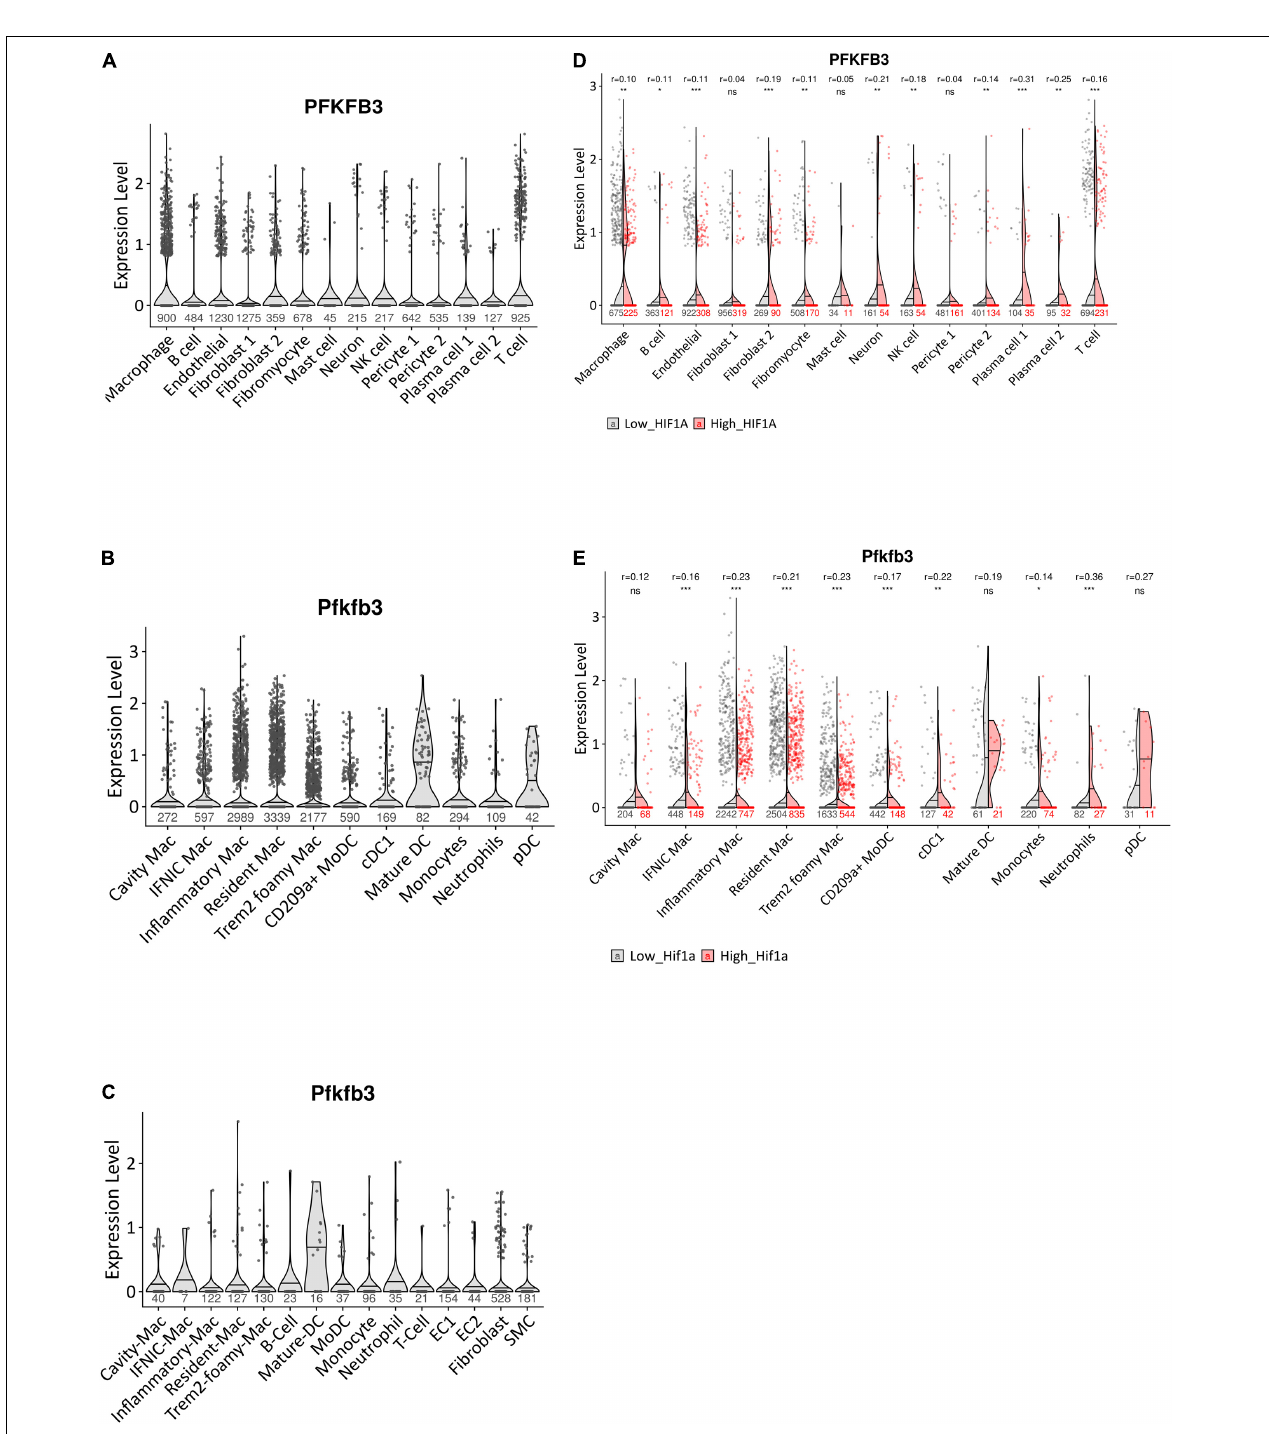
FIGURE 1 | Expression pattern of PFKFB3/Pfkfb3 in human and murine atherosclerosis. (A) Violin plot of PFKFB3 expression in single-cell populations of human atherosclerotic coronary arteries (Wirka et al., 2019). (B) Violin plot of Pfkfb3 expression in single-cell populations of murine atherosclerotic myeloid cells (Zernecke et al., 2020). (C) Violin plot of Pfkfb3 expression in single-cell populations of murine Ldlr - / - LysMCre + / − aortic arch lesions (van Kuijk et al., 2021). (D) Split violin plot of PFKFB3 expression in cells with high versus low HIF1 α signature from human atherosclerotic coronary arteries (Wirka et al., 2019). (E) Split violin plot of Pfkfb3 expression in murine atherosclerotic myeloid cells, with high versus low Hif1 α signature (Zernecke et al., 2020). In (D,E) , Wilcoxon test statistics of FDR-adjusted p -values and r effect sizes are indicated at the top. Sample sizes per cell type indicated under (split) violin plots. CD, cluster of differentiation; cDC, conventional dendritic cell; EC, endothelial cell; HIF1 α , hypoxia-inducible factor 1-alpha; IFNIC, interferon-inducible; Mac, macrophage; moDC, monocyte-derived dendritic cell; NK cell, natural killer cell; pDC, plasmacytoid DC; SMC, smooth muscle cell; TREM2, triggering receptor expressed on myeloid cells 2. ∗ p < 0.05, ∗∗ p < 0.01, ∗∗∗ p <